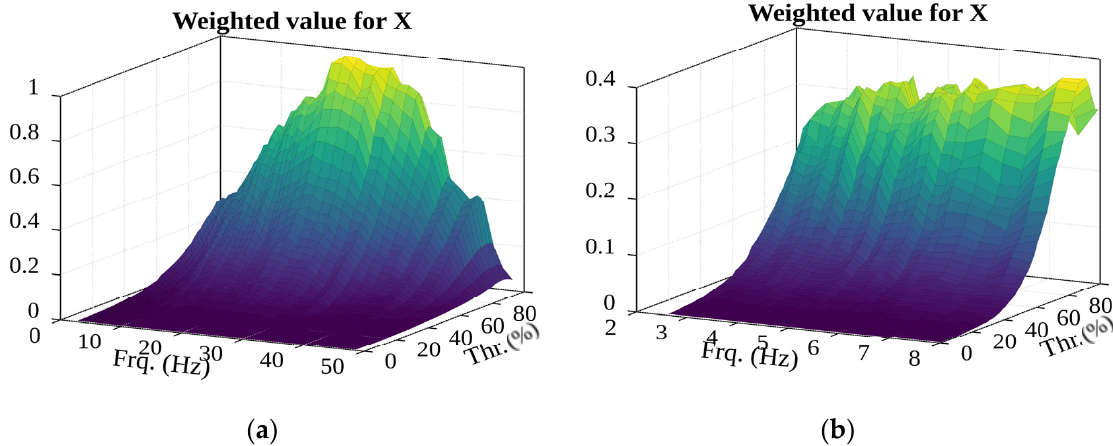
Figure 27. First evaluation of the surface of the weighted value of potential events and RMS (in the ( a )—2.6–49 Hz; ( b )—2.6–8 Hz frequency range).